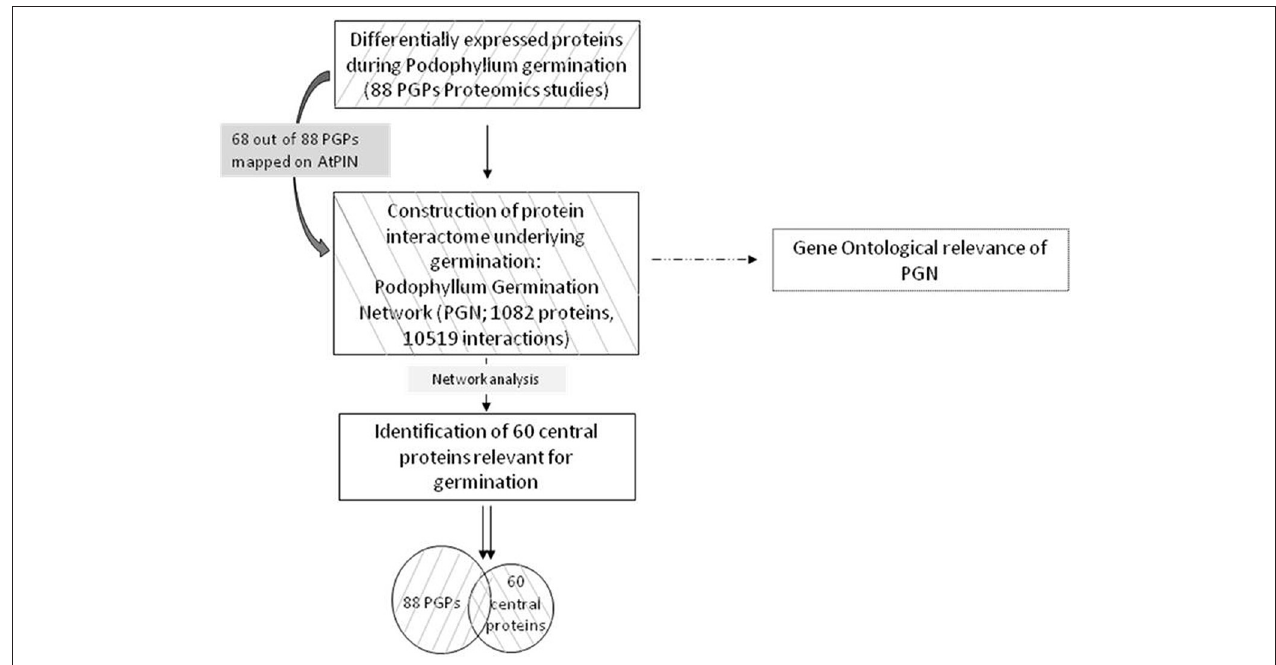
FIGURE 1 | Schematic outlay of the strategy implementing a systems approach for identification of proteins relevant in Podophyllum radicle protrusion step of seed germination. Starting from a seed set of proteins identified with proteomic studies, a protein interactome of underlying molecular mechanisms was constructed, followed by identification of a superset with the help of complex network analysis.